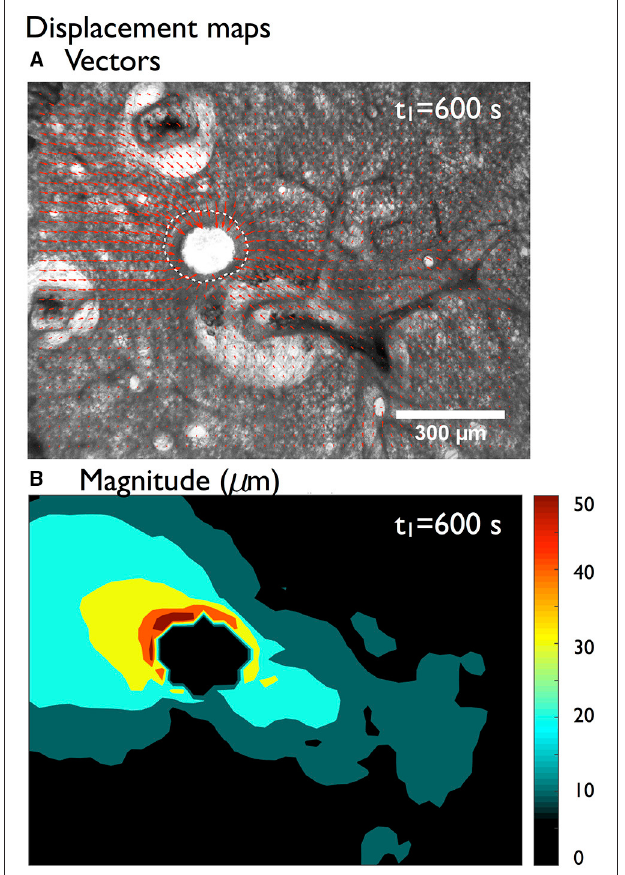
FIGURE 2 | Global analysis of the deformations of the mouse lung slice in Figure 1. Displacement (A) vectors and (B) magnitude of small regions (7 × 7 pixels) of the slice computed between the reference (at t 0 ) and the contracted state (at t 1 ). The boundary of the airway before contraction is represented as a white dashed line. See Movies M1, M2 (and Figures S3–S5 for analyses of additional PCLS) in Supplementary Material.